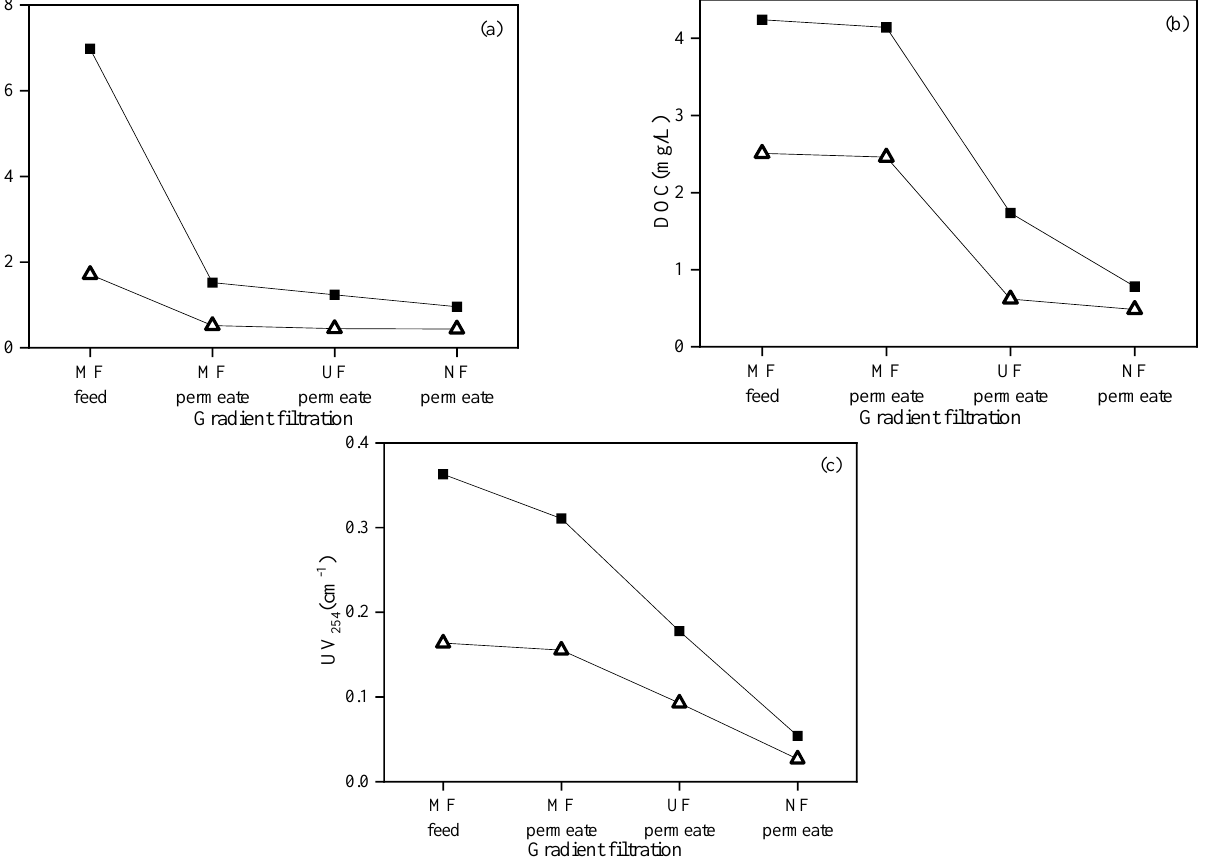
Figure 6. Turbidity ( a ), DOC ( b ), and UV 254 ( c ) during gradient filtration of low- ( △ ) and high-concentration ( ■ ) SWW.